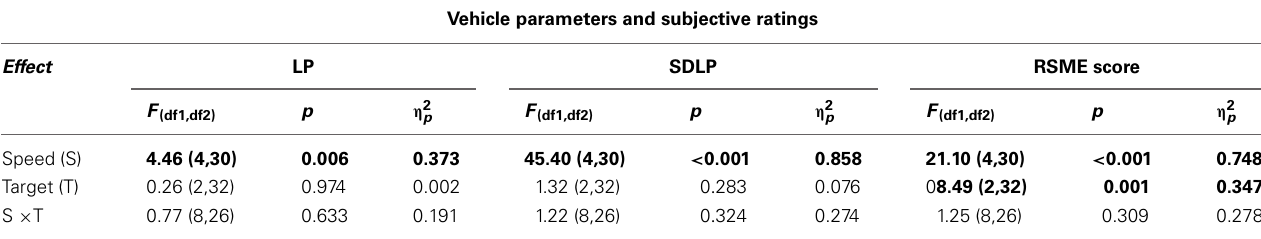
Table 1 | Multivariate test results for vehicle parameters and subjective effort ratings (Figure 1). Vehicle parameters and subjective ratings